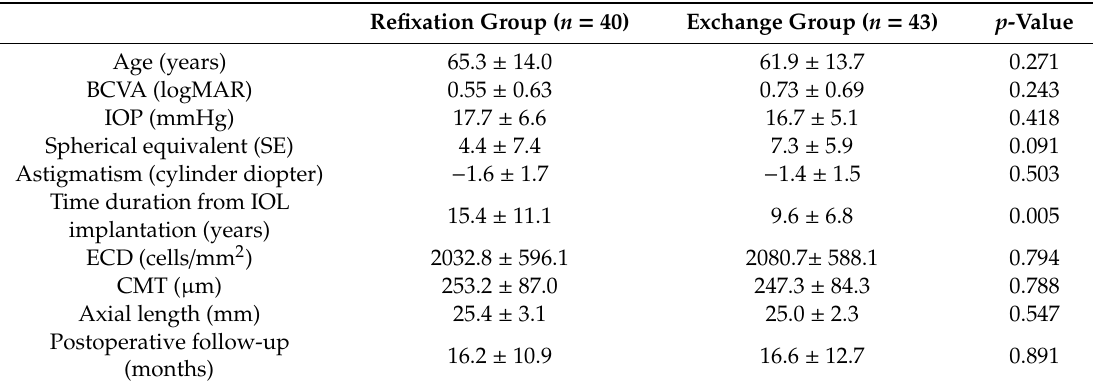
Table 1. Baseline characteristics of the participants in the Refixation and Exchange group.